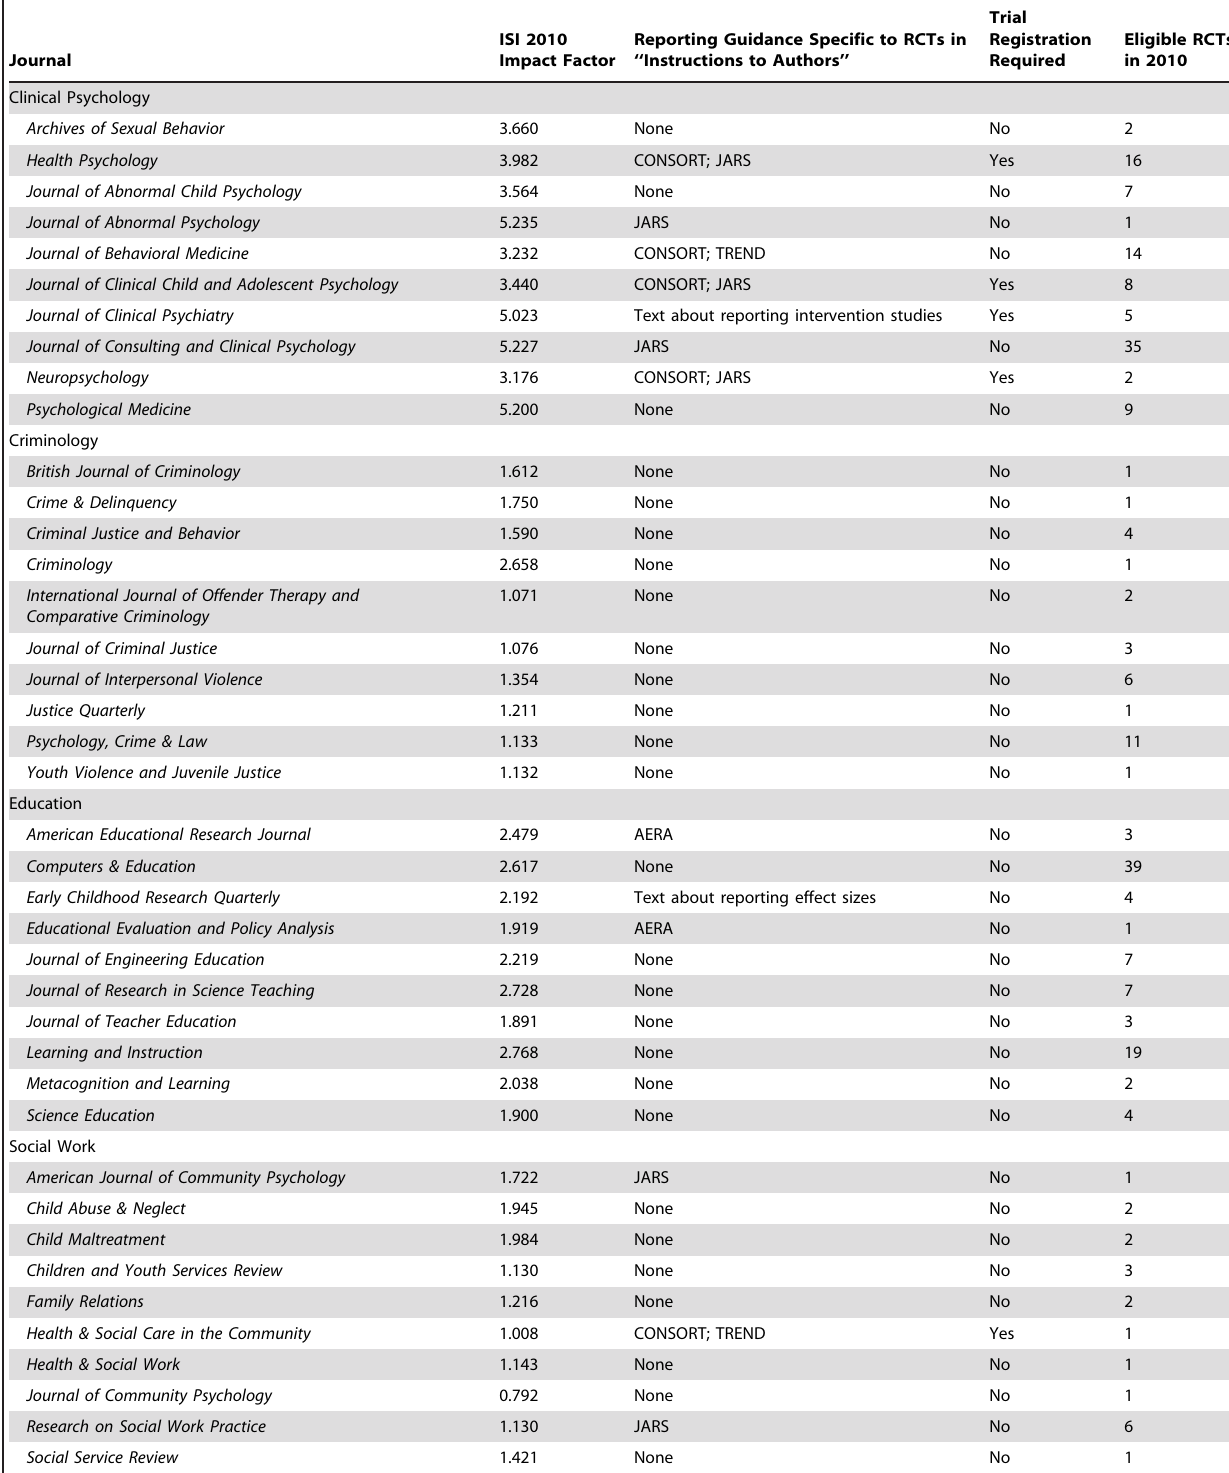
Table 3. Sample of journals included in reporting quality